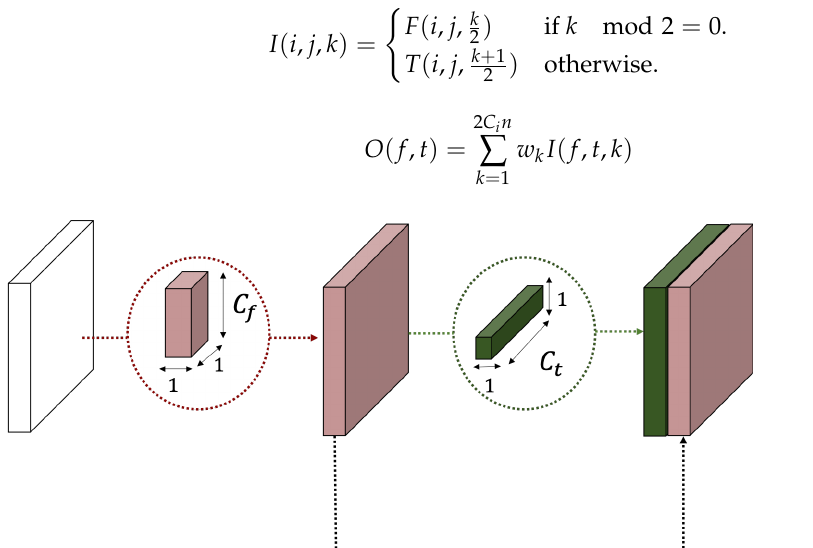
Figure 3. The first step of 2D convolution decomposition. In this step the convolution along frequency is applied, followed by convolution along the time axis.